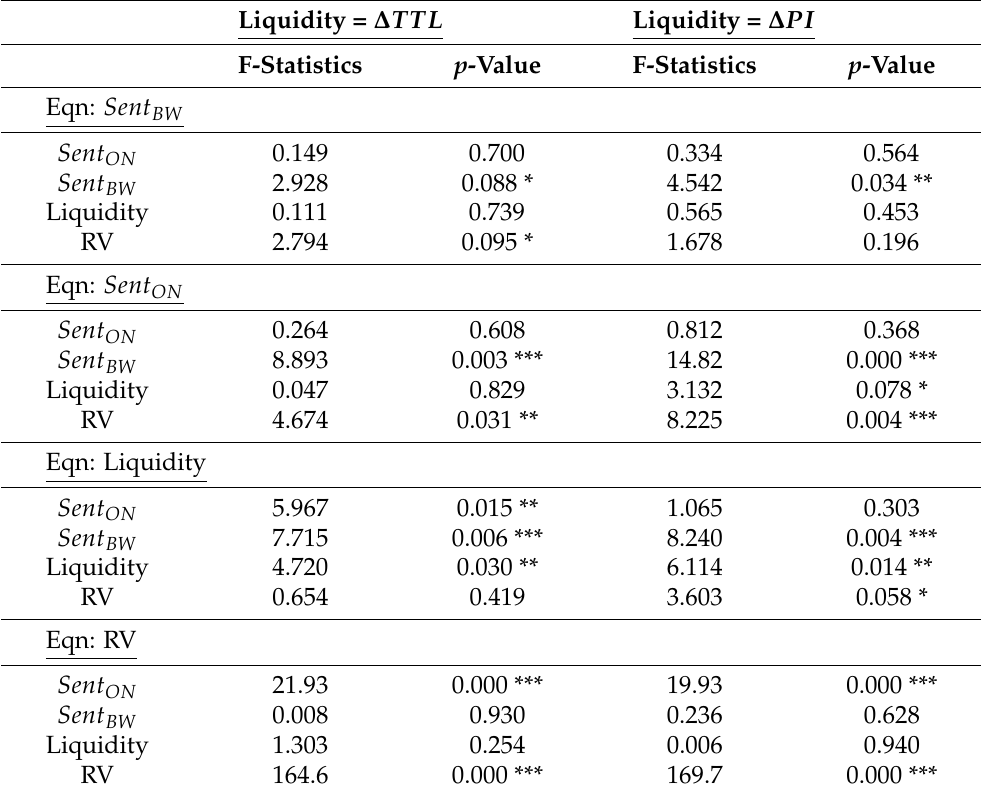
Table 6. Relations among MCASI’s sentiment, liquidity and